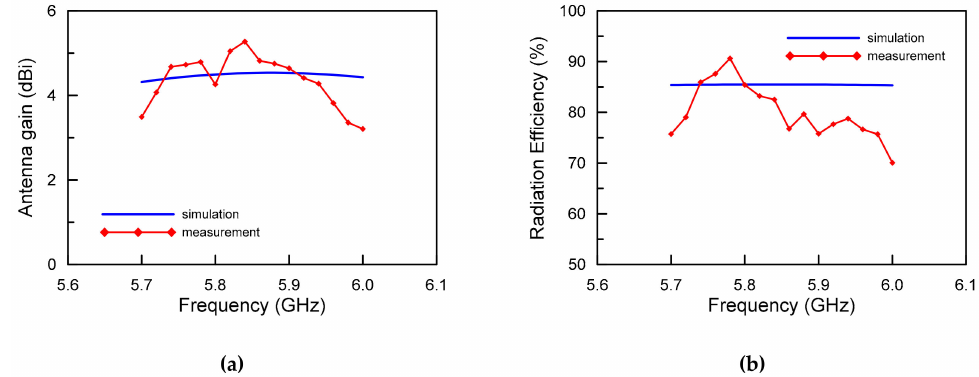
Figure 7. Measurement results of the proposed antenna: the ( a ) realized antenna gain and the ( b ) radiation e ffi